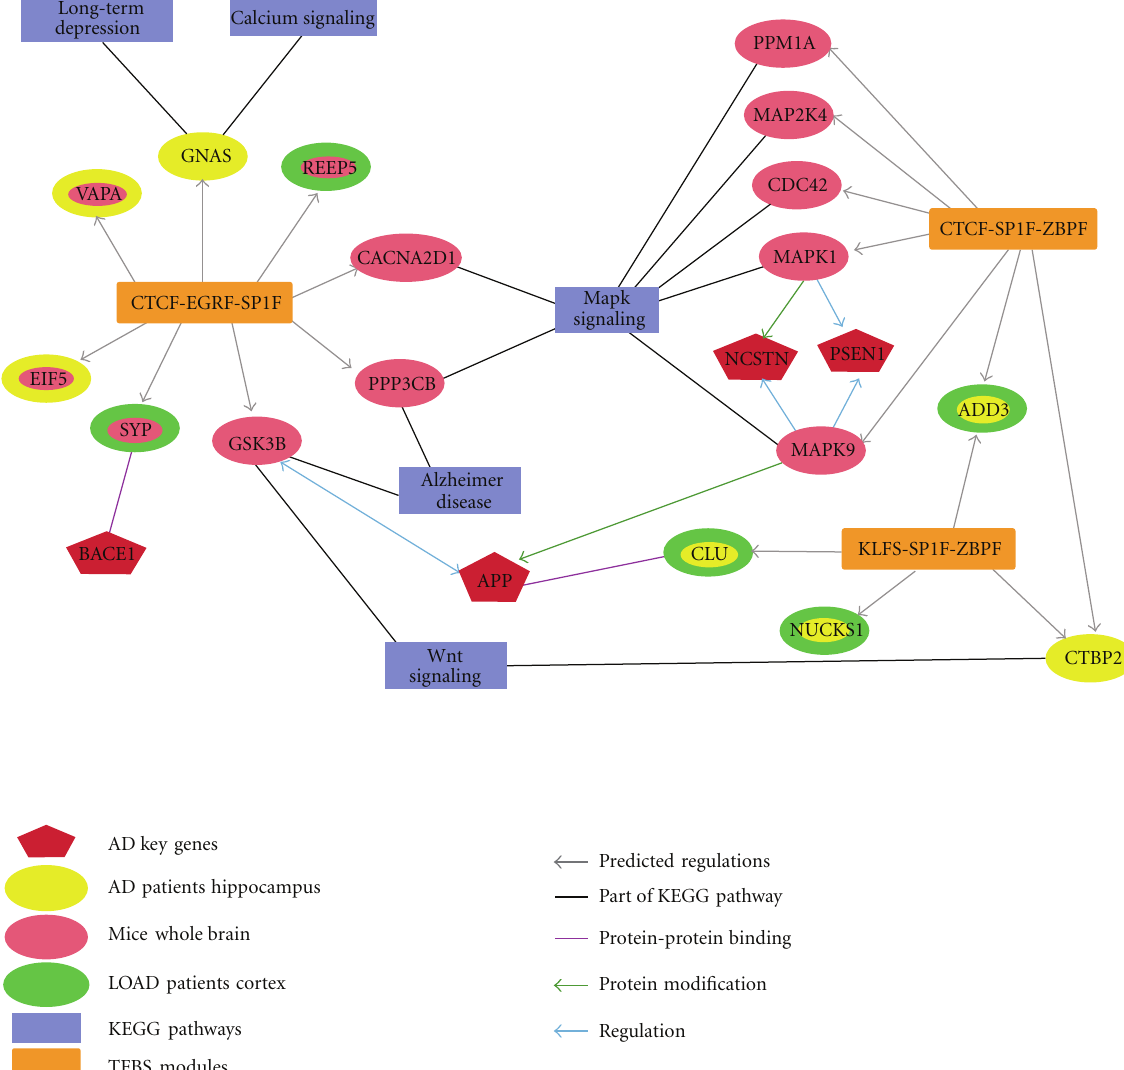
Figure 2: Relations of predicted target genes of three TFBSs modules. This picture summarizes important target genes of the modules, the relation of target genes to KEGG pathways playing a role in AD (blue rectangle), and the relation of the target genes to some AD key genes (red pentagon). The target genes are coloured according to their membership to microarray studies, and some target genes with two colours are derived from analysis of two di ff erent microarray studies. The grey arrows are the predicted regulations of the target genes by the modules (orange rectangle), and the black lines indicate that the target gene is part of the corresponding KEGG pathway. Additionally, three di ff erent relations of the target genes to AD key genes are shown by purple, green, and blue lines, which indicate protein-protein binding, protein modification, and regulation,